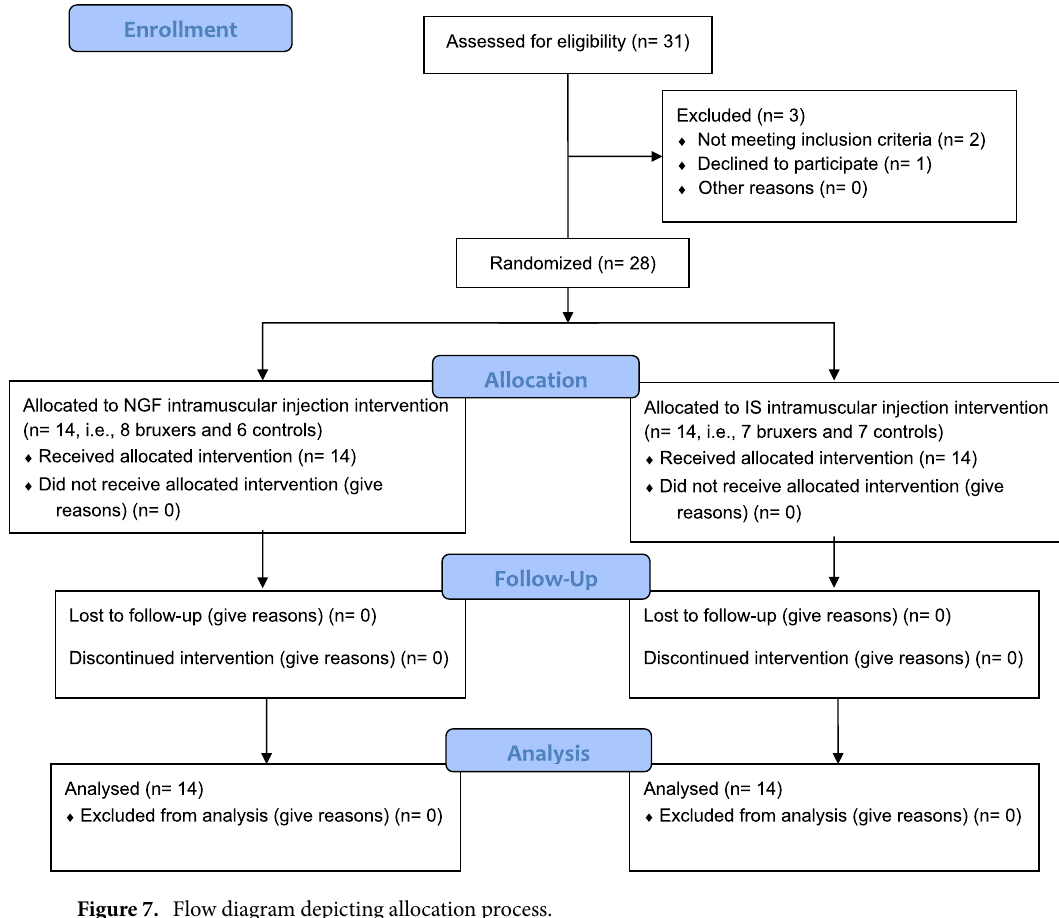
Figure 7. Flow diagram depicting allocation